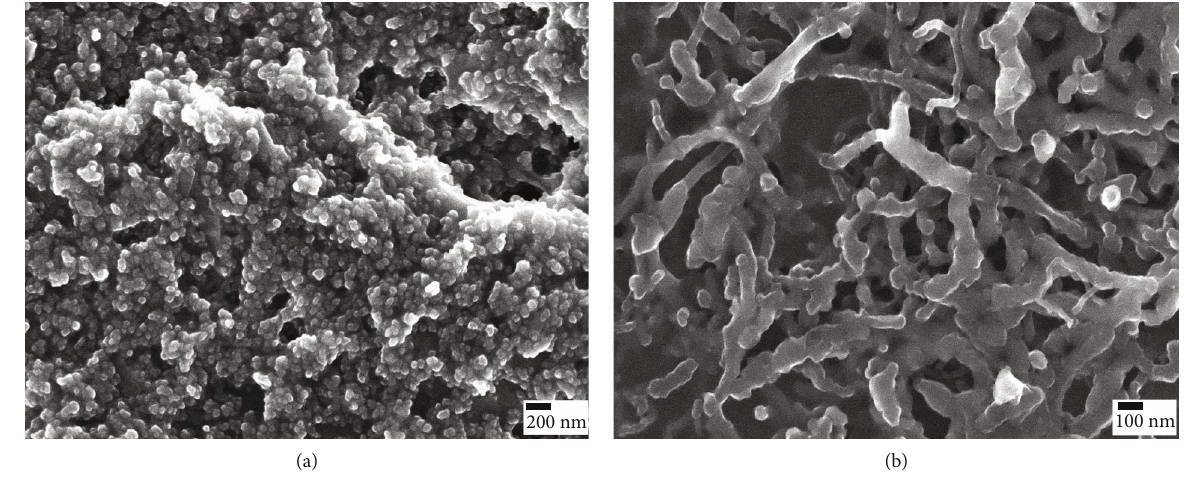
Figure 4: SEM image of (a) bare SPEs and (b) p(1,5-DAN)/SPEs.